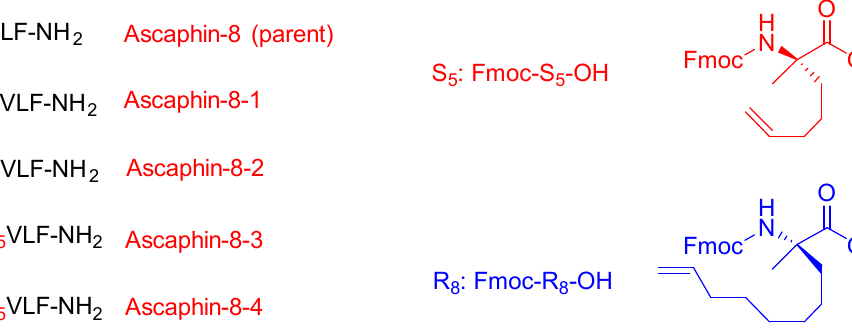
Figure 6. The sequences of the parent Ascaphin-8 peptide and four analogs with different stapling positions. Fmoc-S 5 -OH (Fmoc-(S)-2-(4-pentenyl)Ala-OH) and Fmoc-R 8 -OH (Fmoc-(R)-2-(7-octenyl)Ala-OH) are shown at the right in red and blue, respectively.